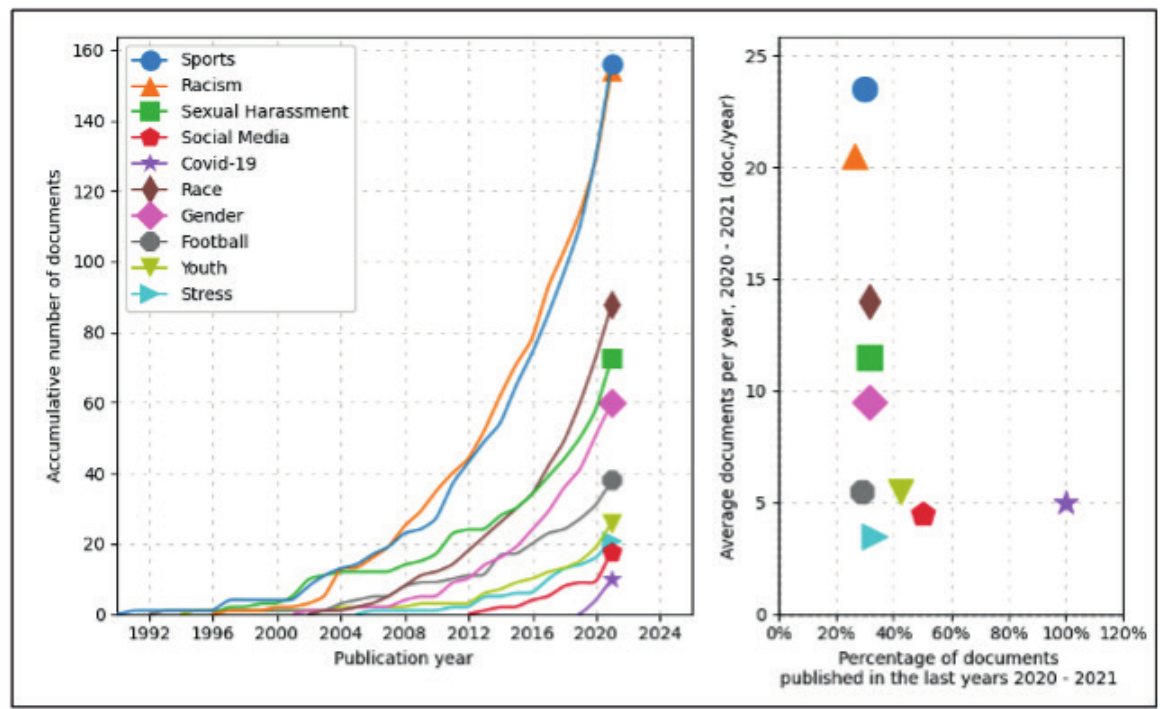
Figure 6. Trending topic author